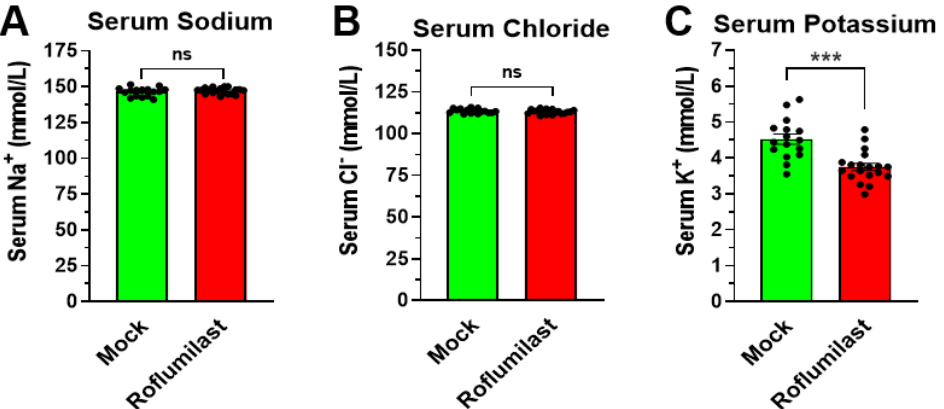
Figure 1. Treatment with the PDE4 inhibitor Roflumilast reduces serum potassium but does not affect sodium or chloride levels. Mice were fasted for 5 h with ad libitum access to water. Animals were then injected with the PAN-PDE4 inhibitor Roflumilast (5 mg/kg, i.p.) or solvent controls (Mock) and blood was collected via cheek bleeds 45 min later. Shown are sodium ( A ), chloride ( B ) and potassium ( C ) levels in the collected blood samples measured using a blood chemistry analyzer. Data represent the mean ± SEM. Statistical significance was determined using Mann–Whitney tests and is indicated as ns ( p > 0.05) or *** ( p <